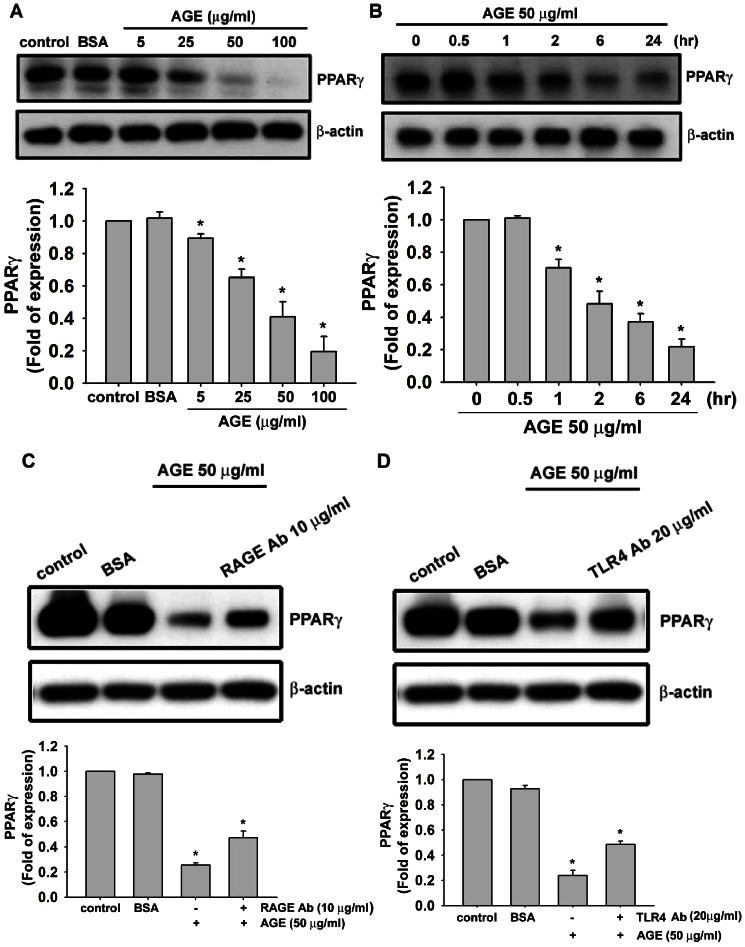
AGEs down-regulate PPARγ protein expression in human OA chondrocytes.Human OA chondrocytes (1×106/ml) were treated with AGEs (5–100 µg/ml) for 24 hours (A) or 0.5–24 hours (B). In C and D, human OA chondrocytes were pretreated with neutralizing antibodies of RAGE (10 µg/ml; C) and TLR4 (20 µg/ml; D) for 1 hour and then stimulated with AGEs (50 µg/ml) for 24 hours. PPARγ protein expression was measured by Western blotting. Densitometric analysis for PPARγ level corrected to β-actin is shown. All data are presented as mean ± SEM for three independent experiments. *: P<0.05 versus control. #: P<0.05 versus AGEs alone.